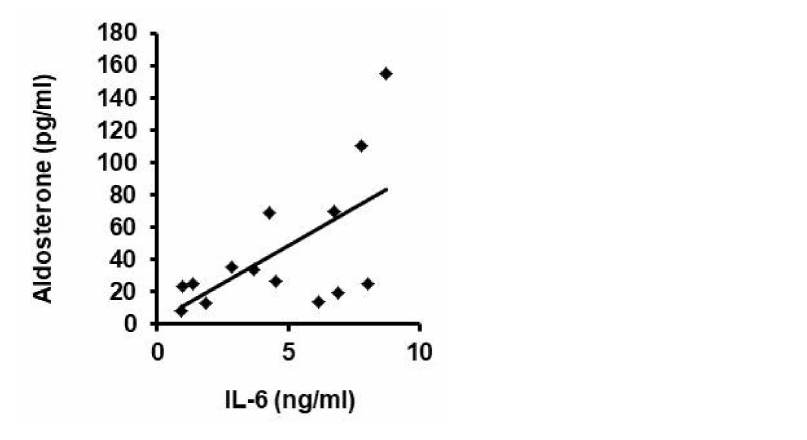
Figure 4. Correlation between blood concentration of IL-6 and aldosterone. IL-6 and aldosterone serum concentrations from patients of cohort 2 not receiving aldosterone blockade are plotted against each other. Linear regression analysis was performed by Pearson correlation (r = 0.608; p =